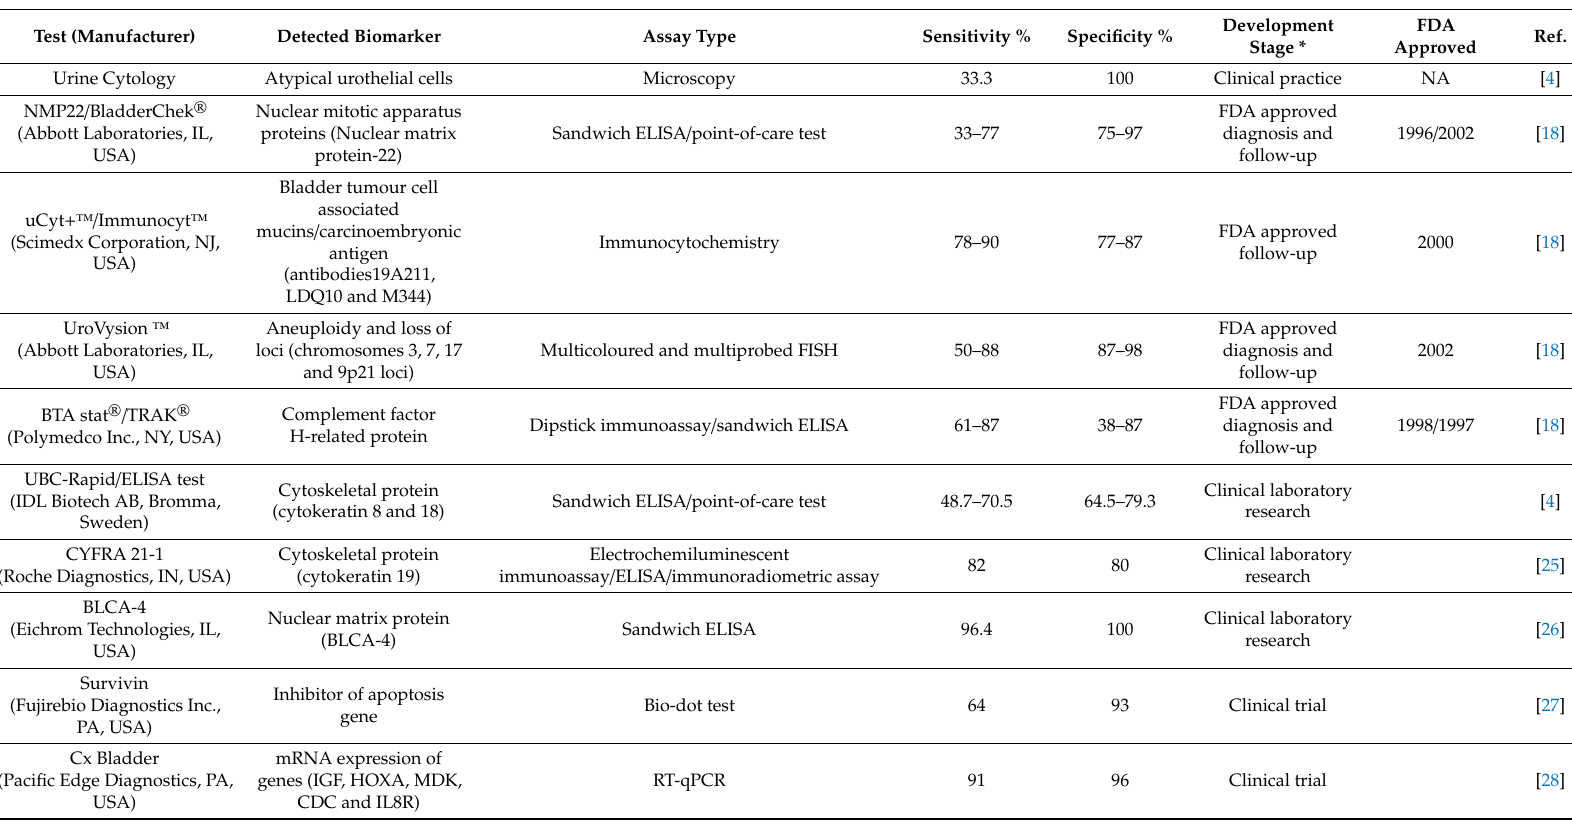
Table 1. Summary of available tests based on the detection of urinary biomarkers [16,17]. A non-systematic literature research was performed using the PubMed / Medline database. Searched by using the following keywords: “bladder cancer”, “urinary markers”, “biomarkers”, “diagnosis”, “detection”, “urine biomarkers”, “NMIBC”, “surveillance”. The search was conducted in